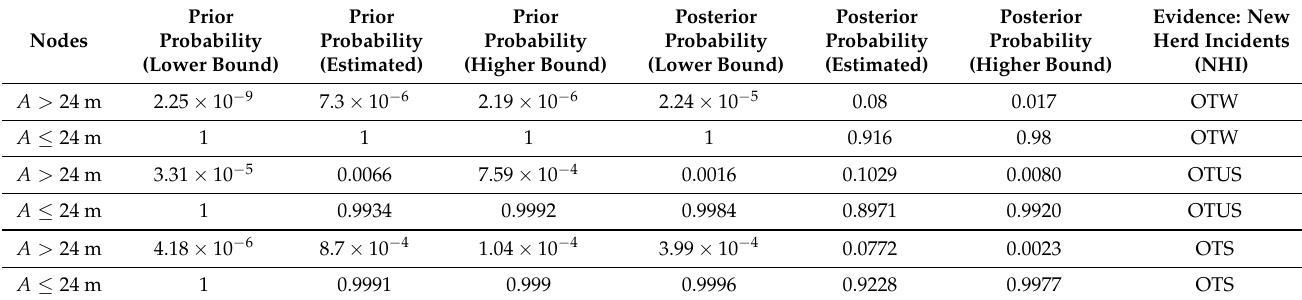
Table 4. Prior and posterior probabilities for node B in high-risk areas of England cattle farms. Prior Nodes